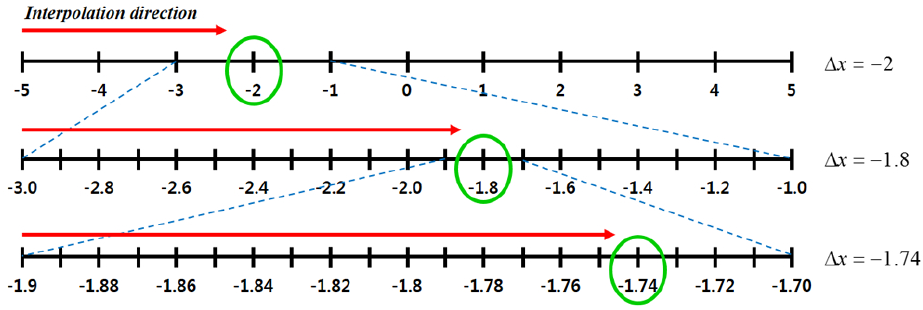
Figure 8. The proposed hierarchical phase correlation